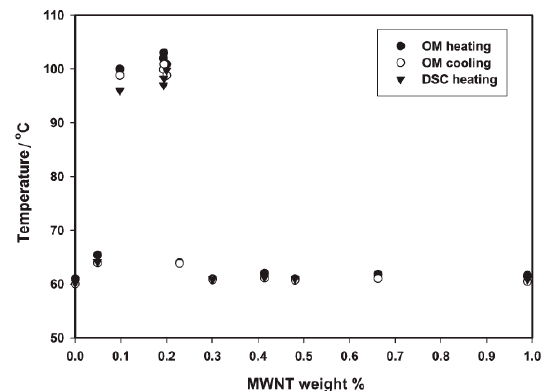
Figure 8. The nematic–isotropic transition temperature (T NI ) versus weight percent of MWCNT: This phase diagram shows chimney type characteristics (OM = Optical Microscopy, DSC = Differential Scanning Calorimetry) [52].